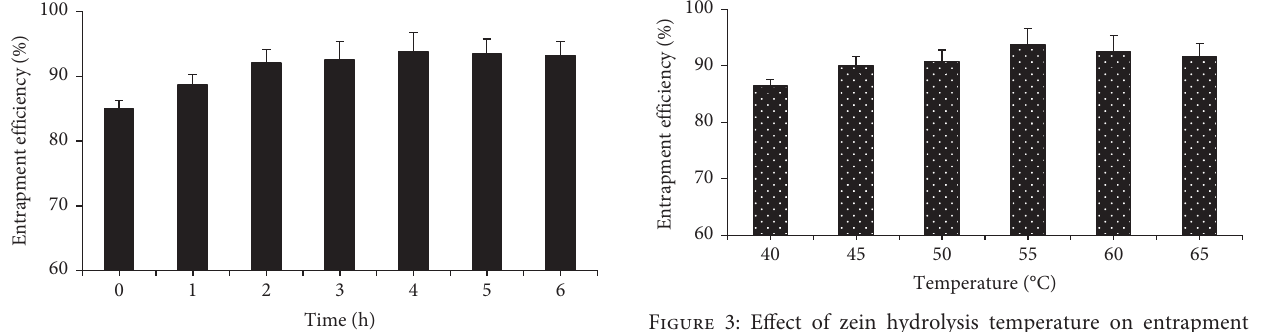
Figure 1: Effect of zein hydrolysis time on entrapment efficiency of lutein. The other hydrolysis conditions were kept constant: pepsin dosage 1.5%, hydrolysis temperature 50 ° C, and pH 3.0. Data were expressed as mean values ± standard deviation ( n �